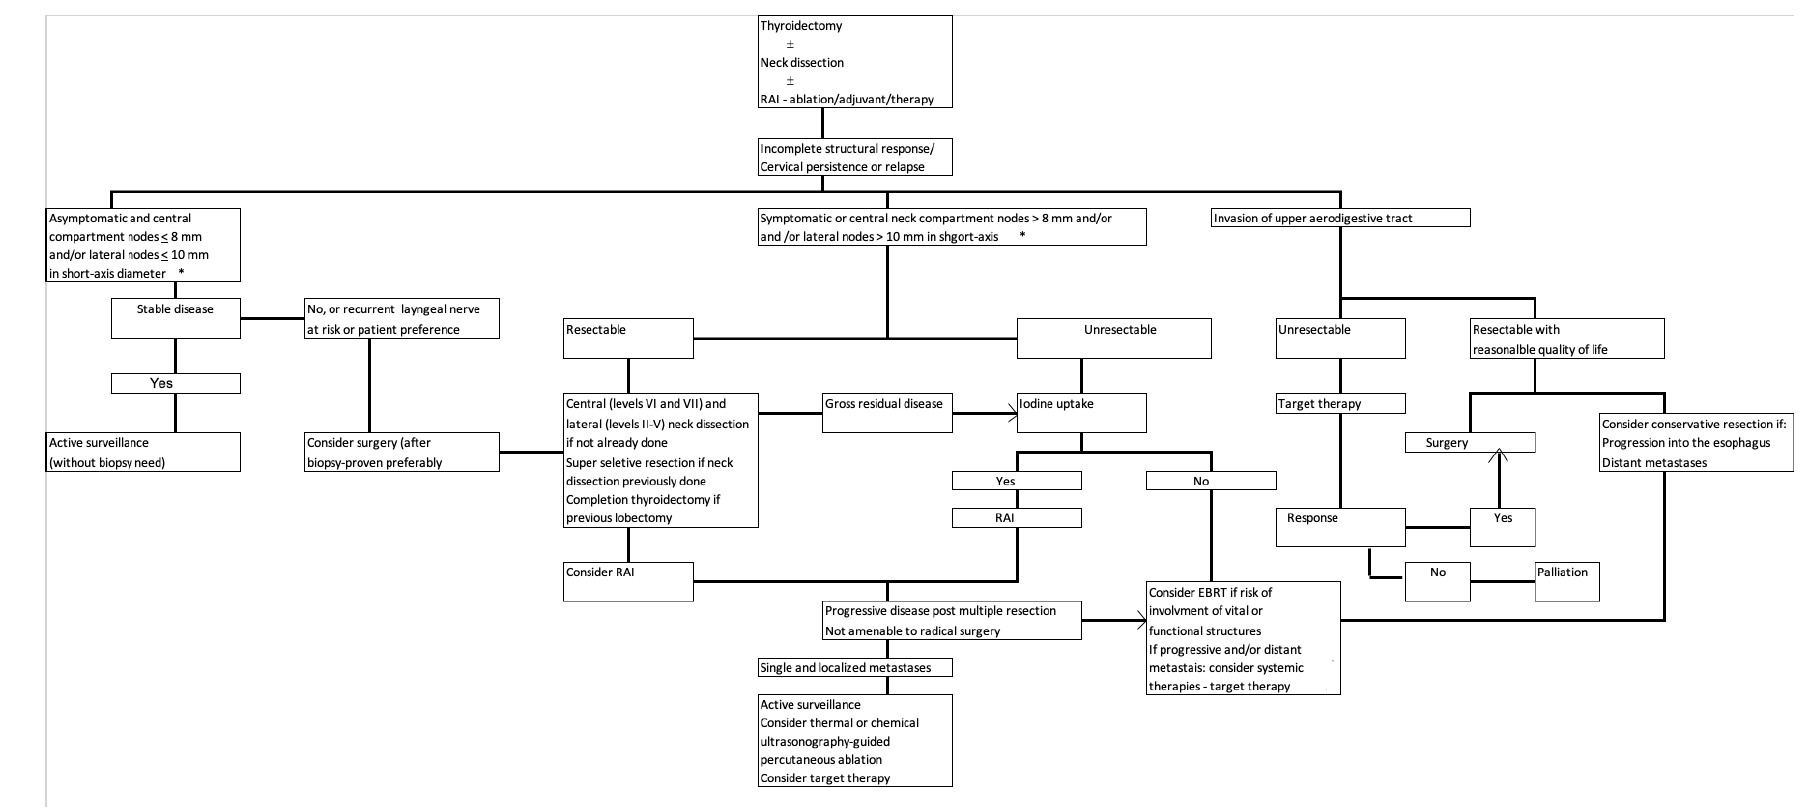
Figure 1. Recommendations for the management of the recurrent neck in well-differentiated thyroid carcinoma. * According to the American Thyroid Association guidelines [1]. RAI: Radioactive iodine. EBRT: External beam radiotherapy. Repeating RAI administrations after a cumulative activity of 600 mCi should be considered on per-patient basis [3]. High-risk patients or in the presence of active disease should receive suppressive doses of levothyroxine to maintain serum TSH levels below 0.1 mIU/mL, except in patients with clinical contraindications.